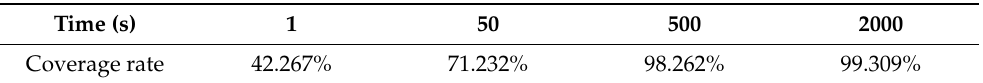
Table 1. Average coverage rate of star spot for different times. Time